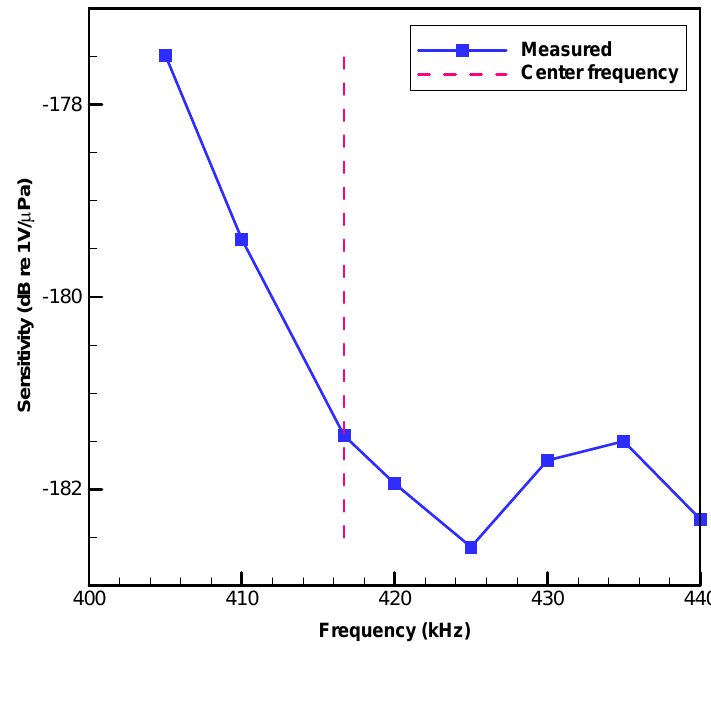
Figure 6. Sensitivity measurements of receivers in the measurement tank at different